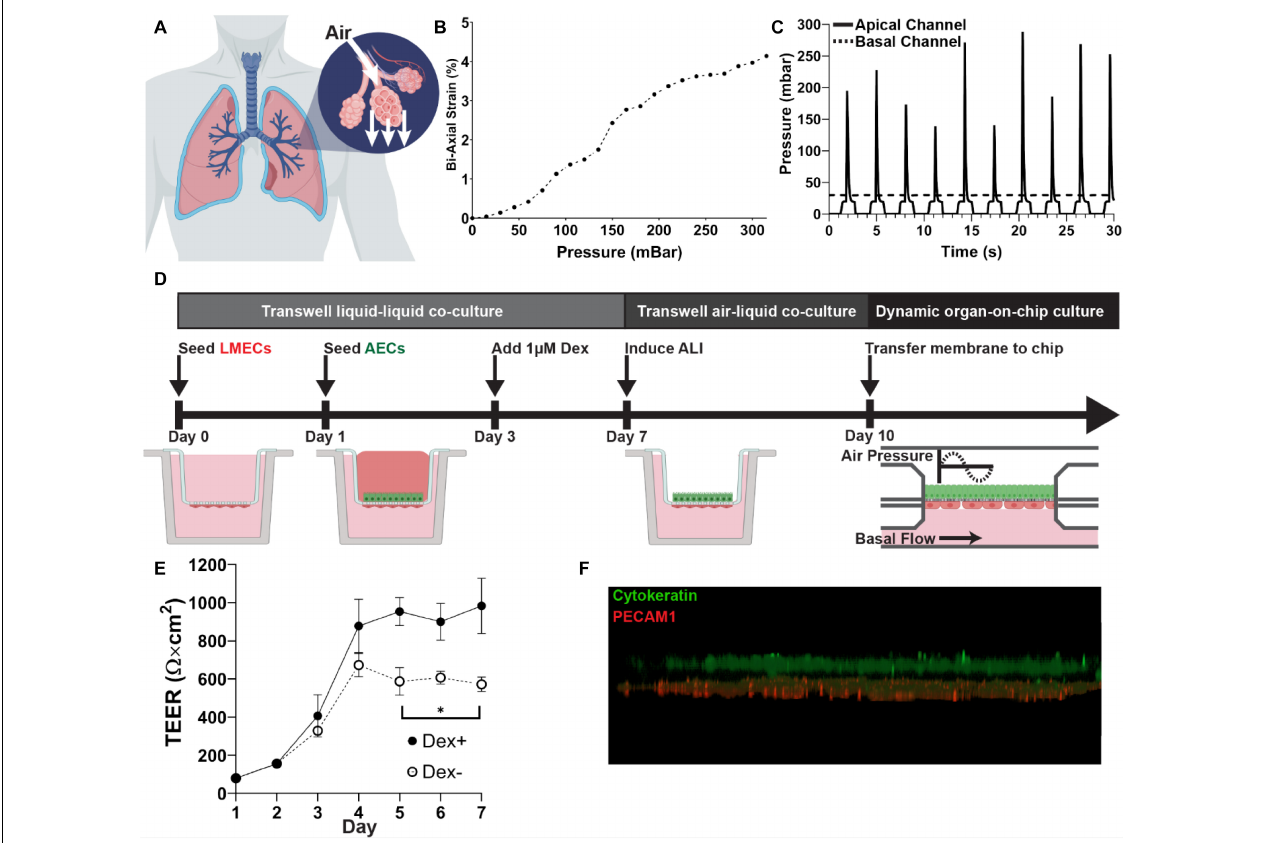
FIGURE 2 | Recapitulating alveolar microenvironment: (A) Cartoon of alveolar expansion during inspiration. Created with BioRender.com. (B) Calculated bi-axial strain in response to applied pressure in the microfluidic chip. (C) Application of a cyclic pressure in the apical channel using a sine wave to mimic breathing at approximately 20 breaths per minute. A constant pressure was applied to the basal channel to drive the flow of PBS. (D) Workflow for development of ALI co-culture. Endothelial cells (LMECs) were first seeded on the basal surface of a transwell culture insert, followed alveolar epithelial cells (AECs). Dexamethasone was added to the apical chamber on Day 3 to enhance the epithelial cell barrier. On Day 7, the ALI was induced by removing media from the apical chamber. On Day 10, the membrane was cut from the transwell support and bonded into the microfluidic chip and exposed to dynamic strain. (E) TEER measurements during liquid-liquid co-culture in the transwell with (Dex +) and without (Dex-) dexamethasone. Statistical analysis by unpaired t -test ( N = 3). (F) 3D visualization of fluorescent z -stack after culture for 24 h under cyclic pressure exposure in the MPS. Cytokeratin (green) staining shows the alveolar endothelial cells on the apical side of the membrane, while PECAM1 (red) staining indicates the lung microvascular endothelial cells on the basal